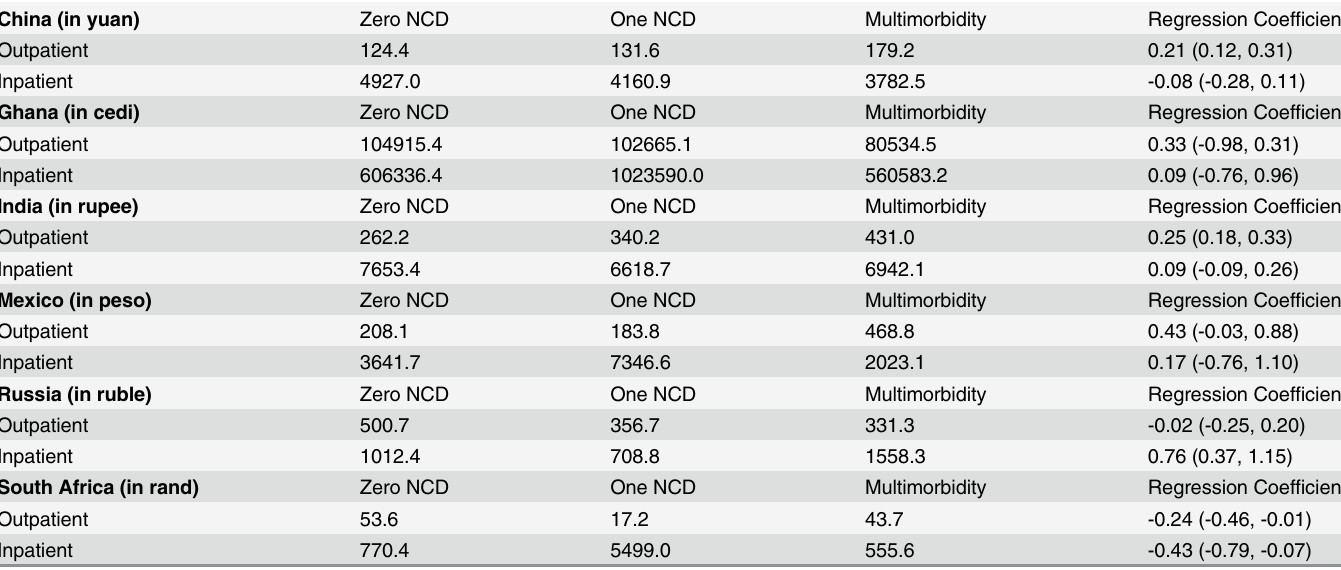
Table 3. Association between number of NCDs and out-of-pocket spending. China (in